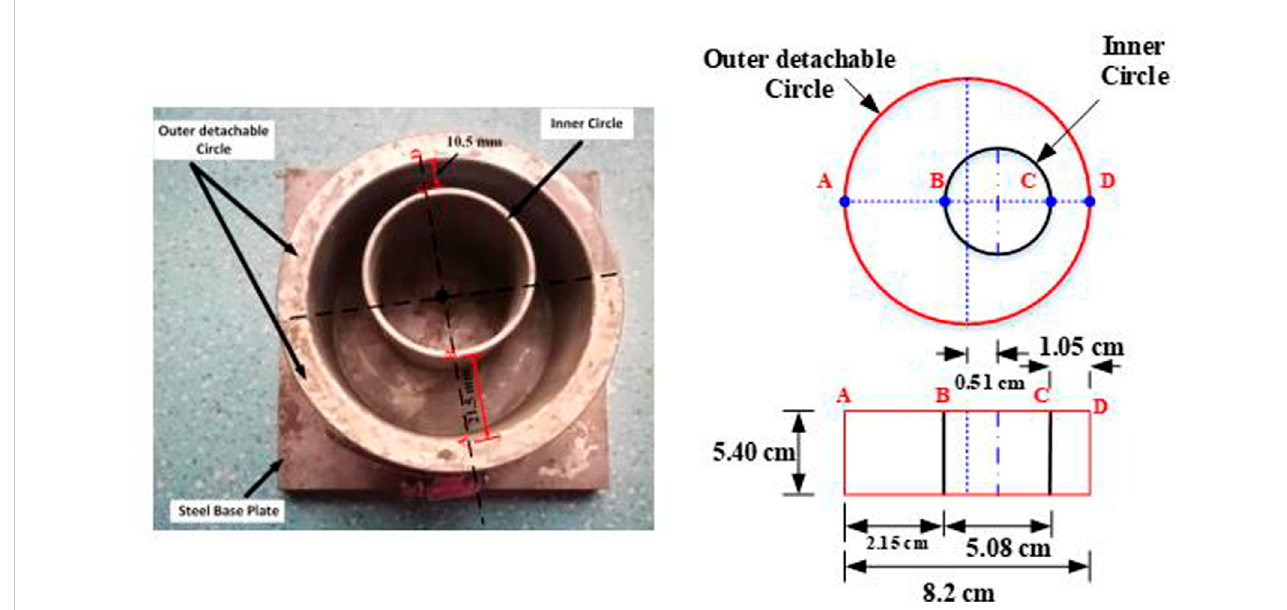
FIGURE 3 Eccentric restrained-shrinkage cracking